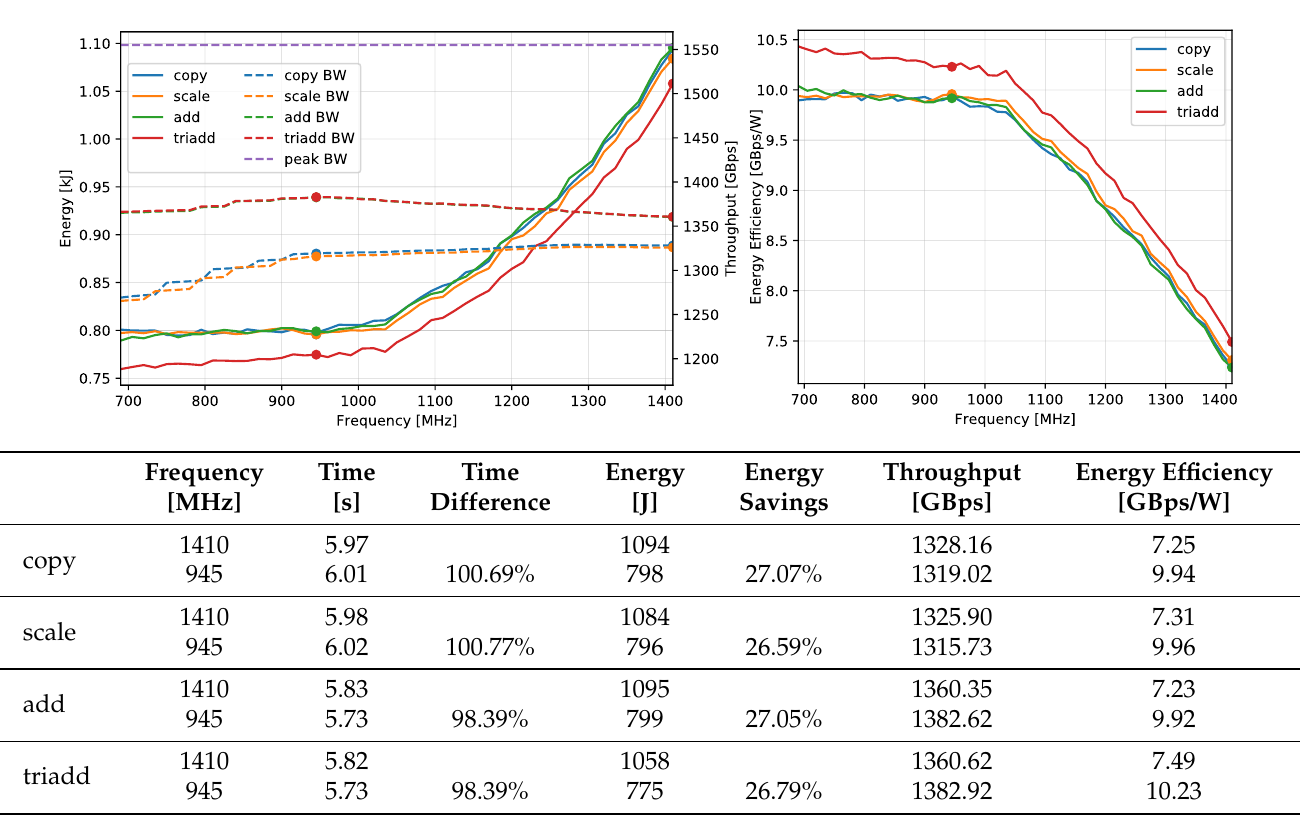
Figure 11. DGX-A100 frequency scaling of the STREAM benchmark. The plot on the left shows consumed energy and throughput. The plot on the right shows the energy efficiency. The table shows the time difference, energy savings, and energy efficiency of the STREAM benchmark functions at the base and at the optimal frequency. The marker in the plot highlights the two frequencies from the table.